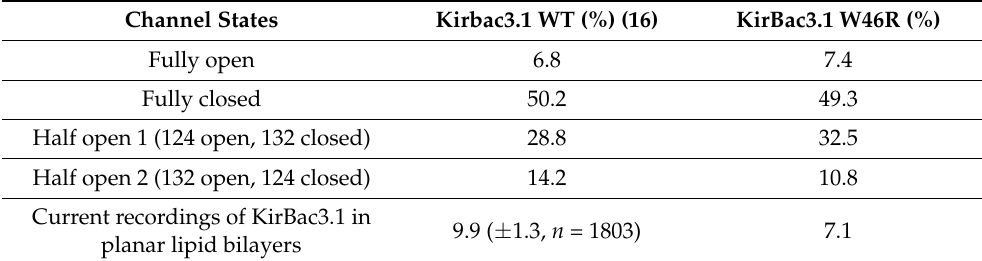
Table 2. Populations (in percentages) of different opening states in the relaxed structures of Kir- Bac W46R obtained through MDeNM simulations and single-channel recording of the mutant and KirBac3.1WT. Channel States Kirbac3.1 WT (%) (16)